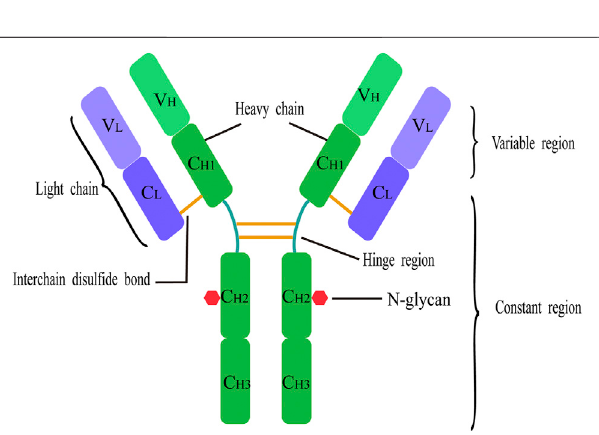
FIGURE 3 | Basic structure of antibody. Each IgG antibody molecule consistsoffour polypeptidechains(twoidenticallightchainsand twoidentical heavy chains joined by disul fi de bonds) and has two antigen-binding sites. Each lightchainand each heavy chainconsistsofavariable regionand a constant region. Each heavy chain consists of a variable domain (VH) and three or four constant domains (CH); each light chain consists of a variable domain (VL) and a single constant domain (CL). Human IgG structure with glycans attached at Asn297 N-glycosylation site in the